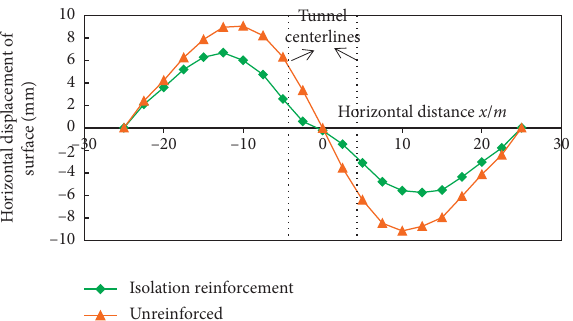
Figure 13: Horizontal displacement curve of the surface before and after reinforcement.